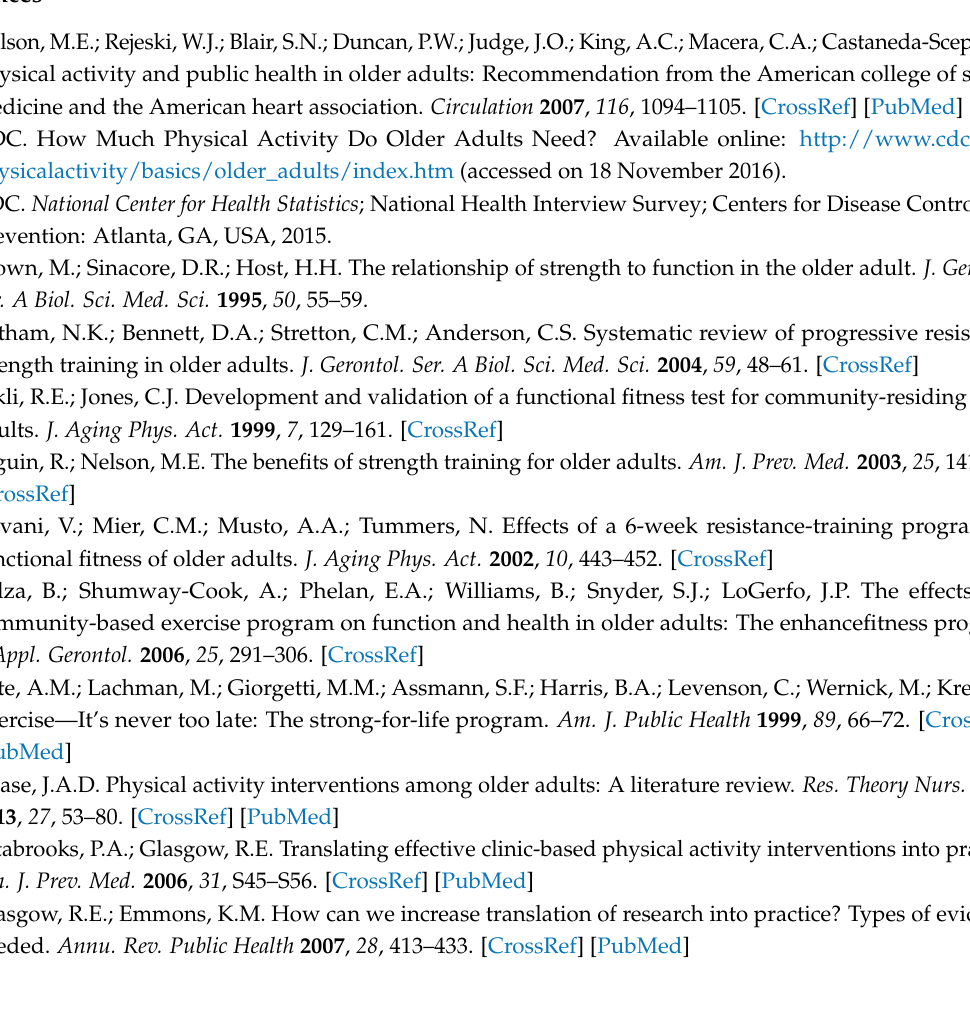
Figure S1: LIFT and SSSH strength training exercises and cool-down stretches, Table S1: Session-by-session behavior change strategies and activities for LIFT, Table S2: Physical activity and fruit and vegetable tracking sheet. Acknowledgments: The Physical Activity Research and Community Implementation (PARCI) lab would like to acknowledge members of the Physical Activity Leadership Team for their willingness to participate in this study. Author Contributions: Meghan L. Wilson and Samantha M. Harden and other members of the IRPP conceived and designed the feasibility trial. Meghan L. Wilson and S.H. managed and collected data pertaining to this study. Thomas E. Strayer III and Meghan L. Wilson co-led the statistical analyses. Meghan L. Wilson, Thomas E. Strayer III and Samantha M. Harden analyzed the data. Rebecca Davis contributed practice-based evidence, materials, and feedback tools for this trial. Meghan L. Wilson and Samantha M. Harden led the writing of the paper. All authors contributed to edits and review of this